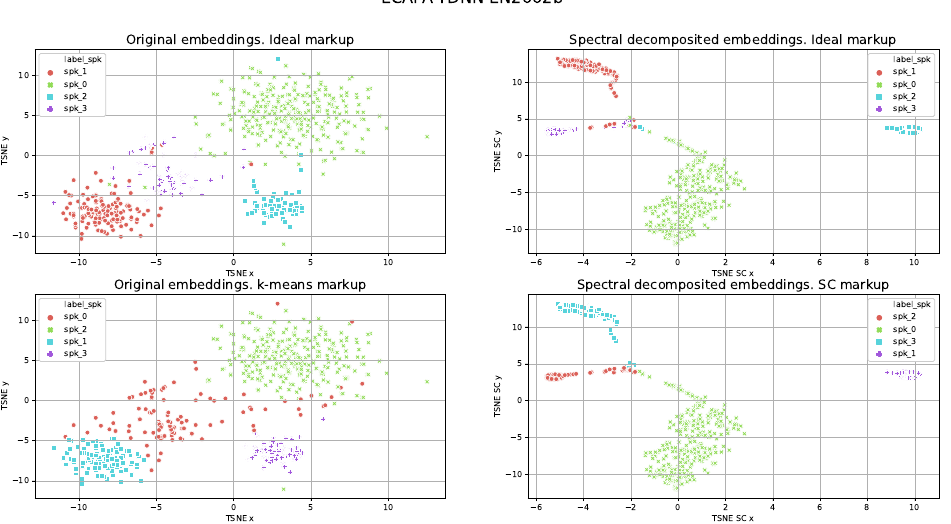
Figure 4. Results of TSNE visualization computed by means of the ECAPA-TDNN model and EN2002b lapel-mix file from the AMI evaluation dataset. All overlapping speech segments were removed to reduce uncertainty. In the left parts of the images, the original speaker embeddings are used; in the right parts the speaker embeddings after spectral decomposition are